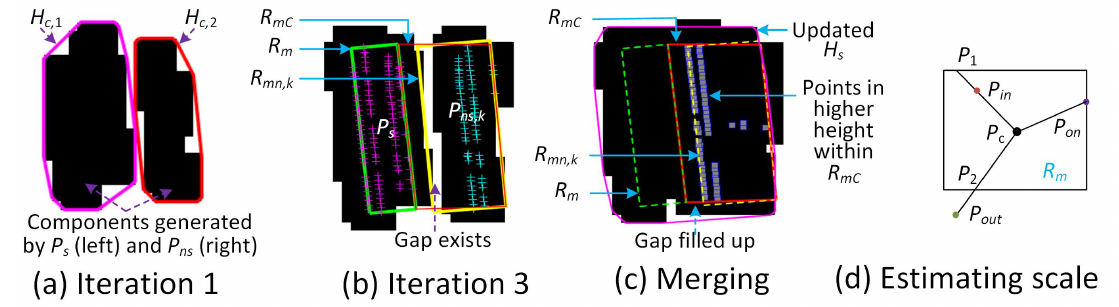
Figure 10. Binary masks of points in slices during pylon extraction: ( a – c ) Within the binary images, black pixels indicate “true” and white pixels indicate “false” for pylons; and ( d ) how to estimate scaling